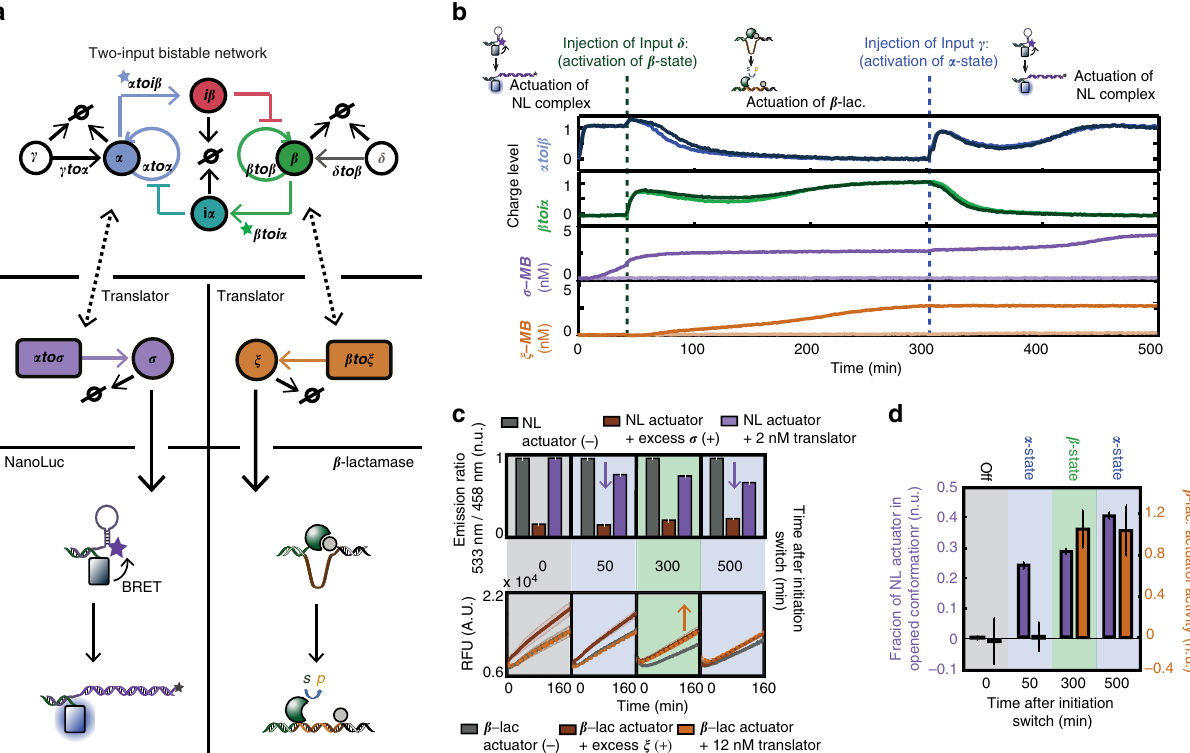
Fig. 6 Control of two orthogonal enzymatic actuators by a switchable memories circuit. a Schematics of the experiment in which the switch controls a NanoLuc-based actuator and a self-inhibitory TEM1 β -lactamase construct. b – d Results of the experiments, carried out as described in the Methods, using 20 nM β toi α , 15 nM α toi β , 24 nM β to β , 10 nM α to α , γ to α , and δ to β , 15 U mL − 1 Bst 2.0 WarmStart DNA polymerase, 10 U mL − 1 Nt. bstNBI, and 200 nM ttRecJ. Reactions were performed in presence of the actuators or MBs. The switch was initiated with 1 nM α . b The graphs show the dynamics of the switch and the production of σ and ξ measured using MBs (5 nM MB σ and 2.5 nM MB ξ ) (Supplementary Fig. 17) in absence (light color) and in presence (dark color) of the translator modules (2 nM α to σ and 12 nM β to ξ ). The charge level is the normalized fl uorescence of the signal of DY530 and FAM fl uorophores, which is 0 in the absence of template ’ s input primer and 1 at the steady-state value of β and α , respectively. The dotted lines show the time points at which 30 nM of the Inputs δ and γ were added. In parallel, experiments were run where the MBs were replaced with the enzymatic actuators (5 nM of the NanoLuc-based actuator and 2.5 nM TEM1 β -lactamase actuator). c , d The state of the actuators was measured at four time points including negative ( − ) and positive (+) controls (Supplementary Figs. 13, 14 and Methods). Error bars and shaded area ’ s represent the standard error of the mean of the experiments. Experiments were performed in plurality ( > 3) and at three different days. c The bar graphs displaying the BRET ratio were normalized to the mean of the negative controls for a clear visualization (Supplementary Fig. 14 displays the raw data). d The activity or fraction in opened conformation of the actuators were calculated by normalizing to positive and negative controls